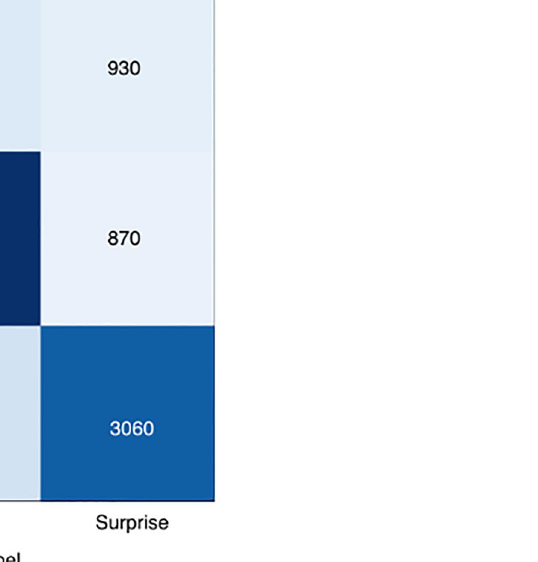
Figure 8. Confusion matrix using ShuffleNetV2 model